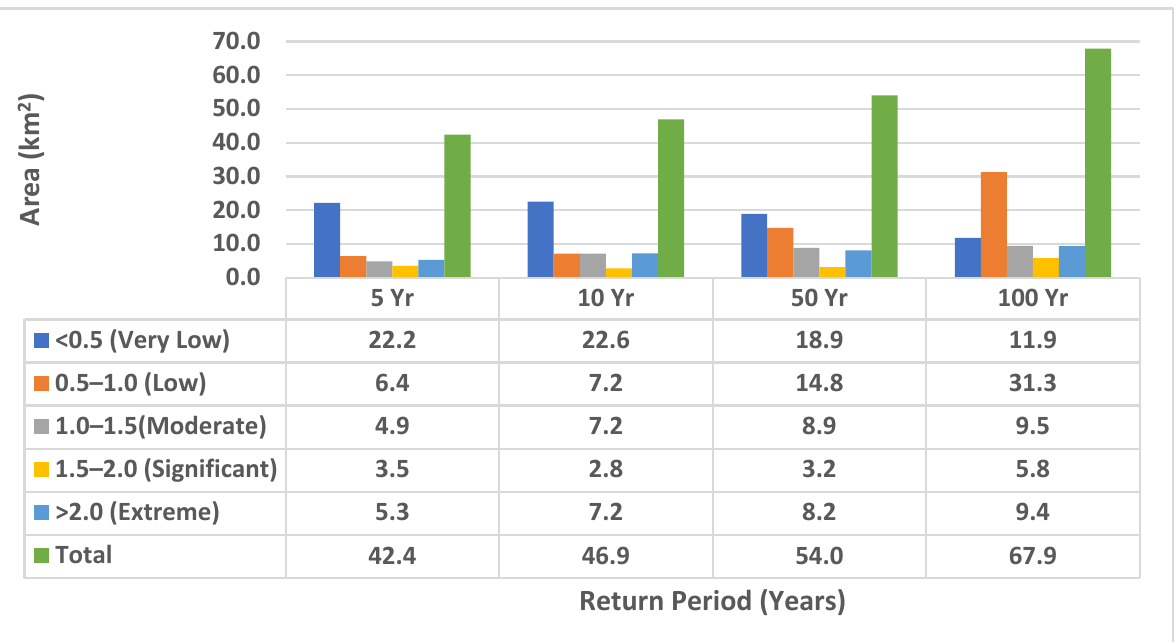
Figure 12. Risk classification of Subsistence Farming Land Cover Type.